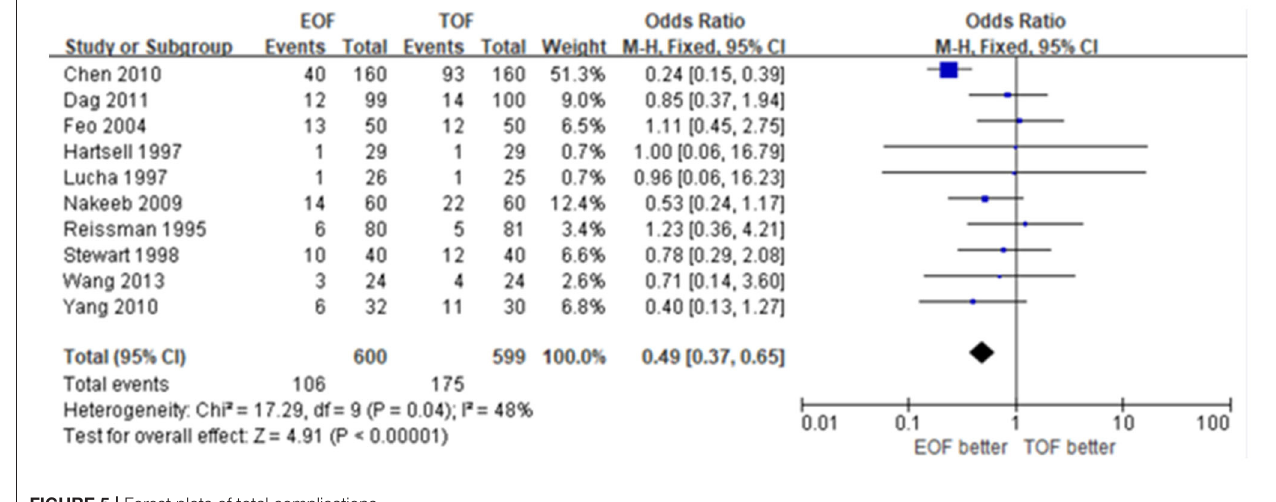
FIGURE 5 | Forest plots of total complications.